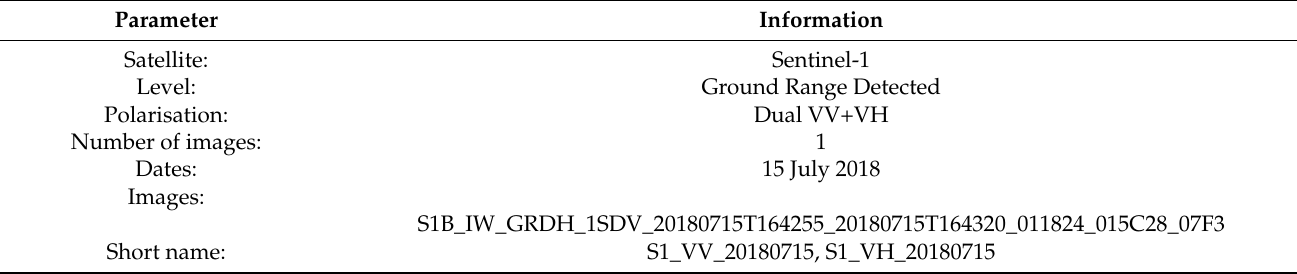
Table 3. Characteristics of the Sentinel-1 satellite